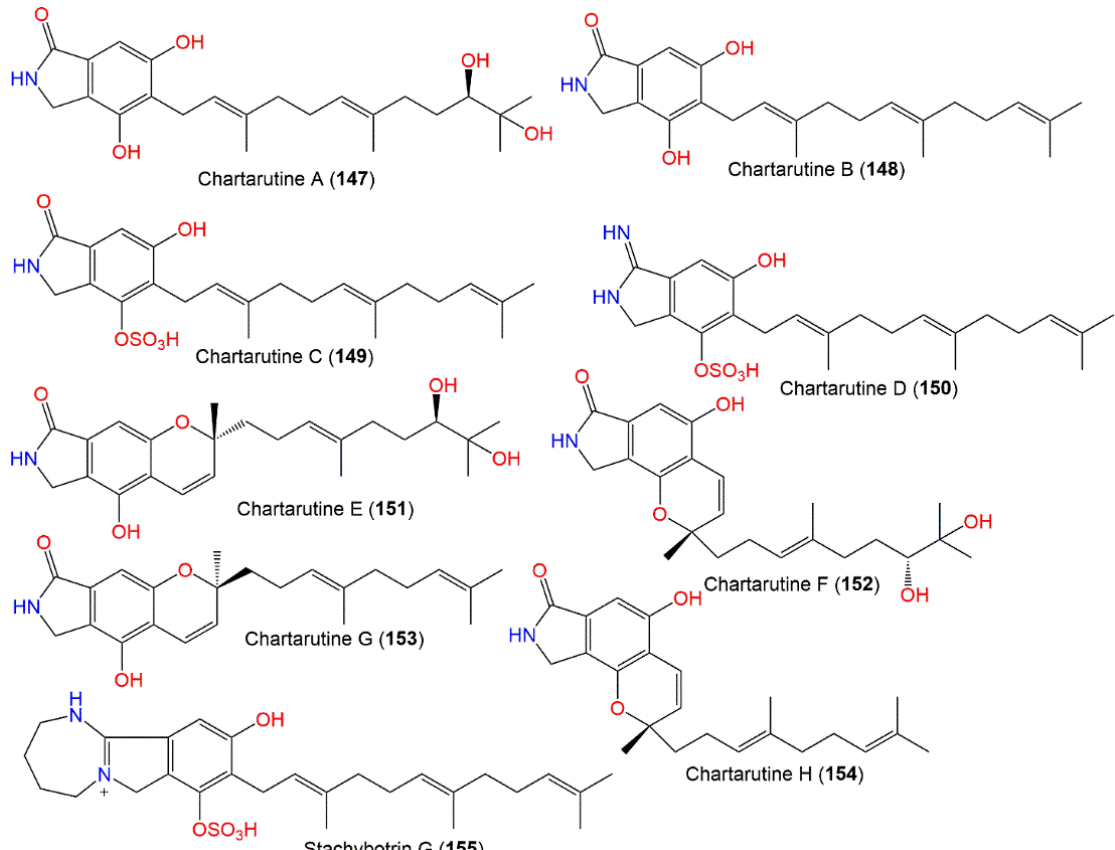
Figure 19. Structures of isoindoline derivatives ( 147 – 155 ) reported from S . chartarum . It had no cytotoxic (versus P388, A-549, HL-60, BEL-7402, and Hela cells), antiviral (versus HIV and H1N1), and antibacterial (versus M. phlei , S. aureus , Colibacillus sp., and Blastomyces albicans ) potential [105]. Ma et al. proposed that 155 is generated through both mevalonate and polyketide pathways, with subsequent modifications, including amidation, cyclizing, and sulfation (Scheme